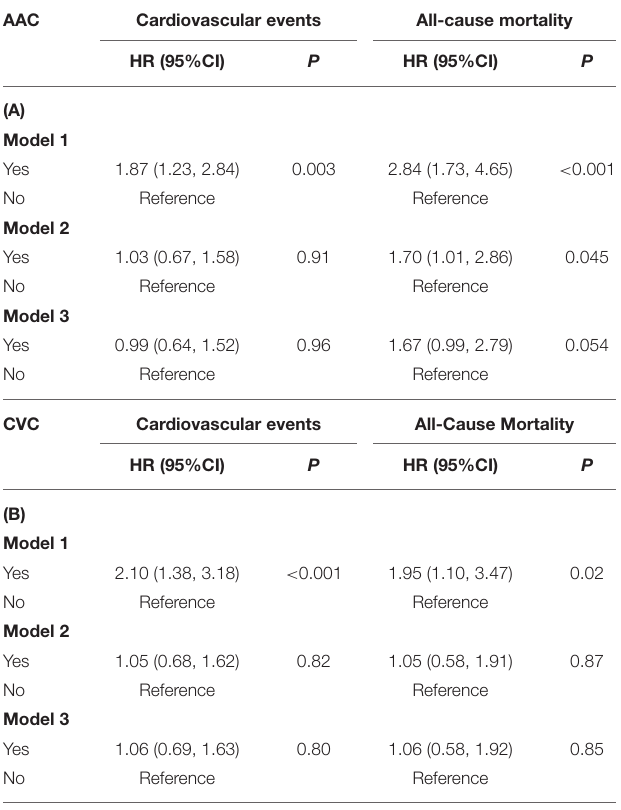
TABLE 5 | Cox proportional hazard regression model for cardiovascular events with CVC stratified by CKD stages.